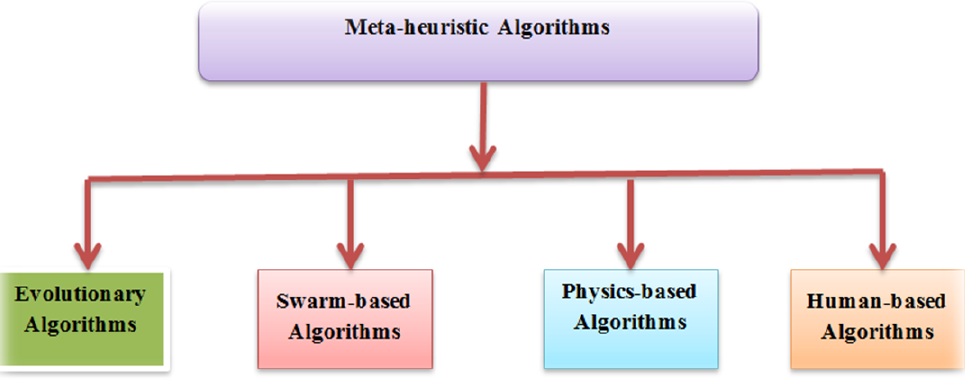
Figure 1. Meta-heuristic